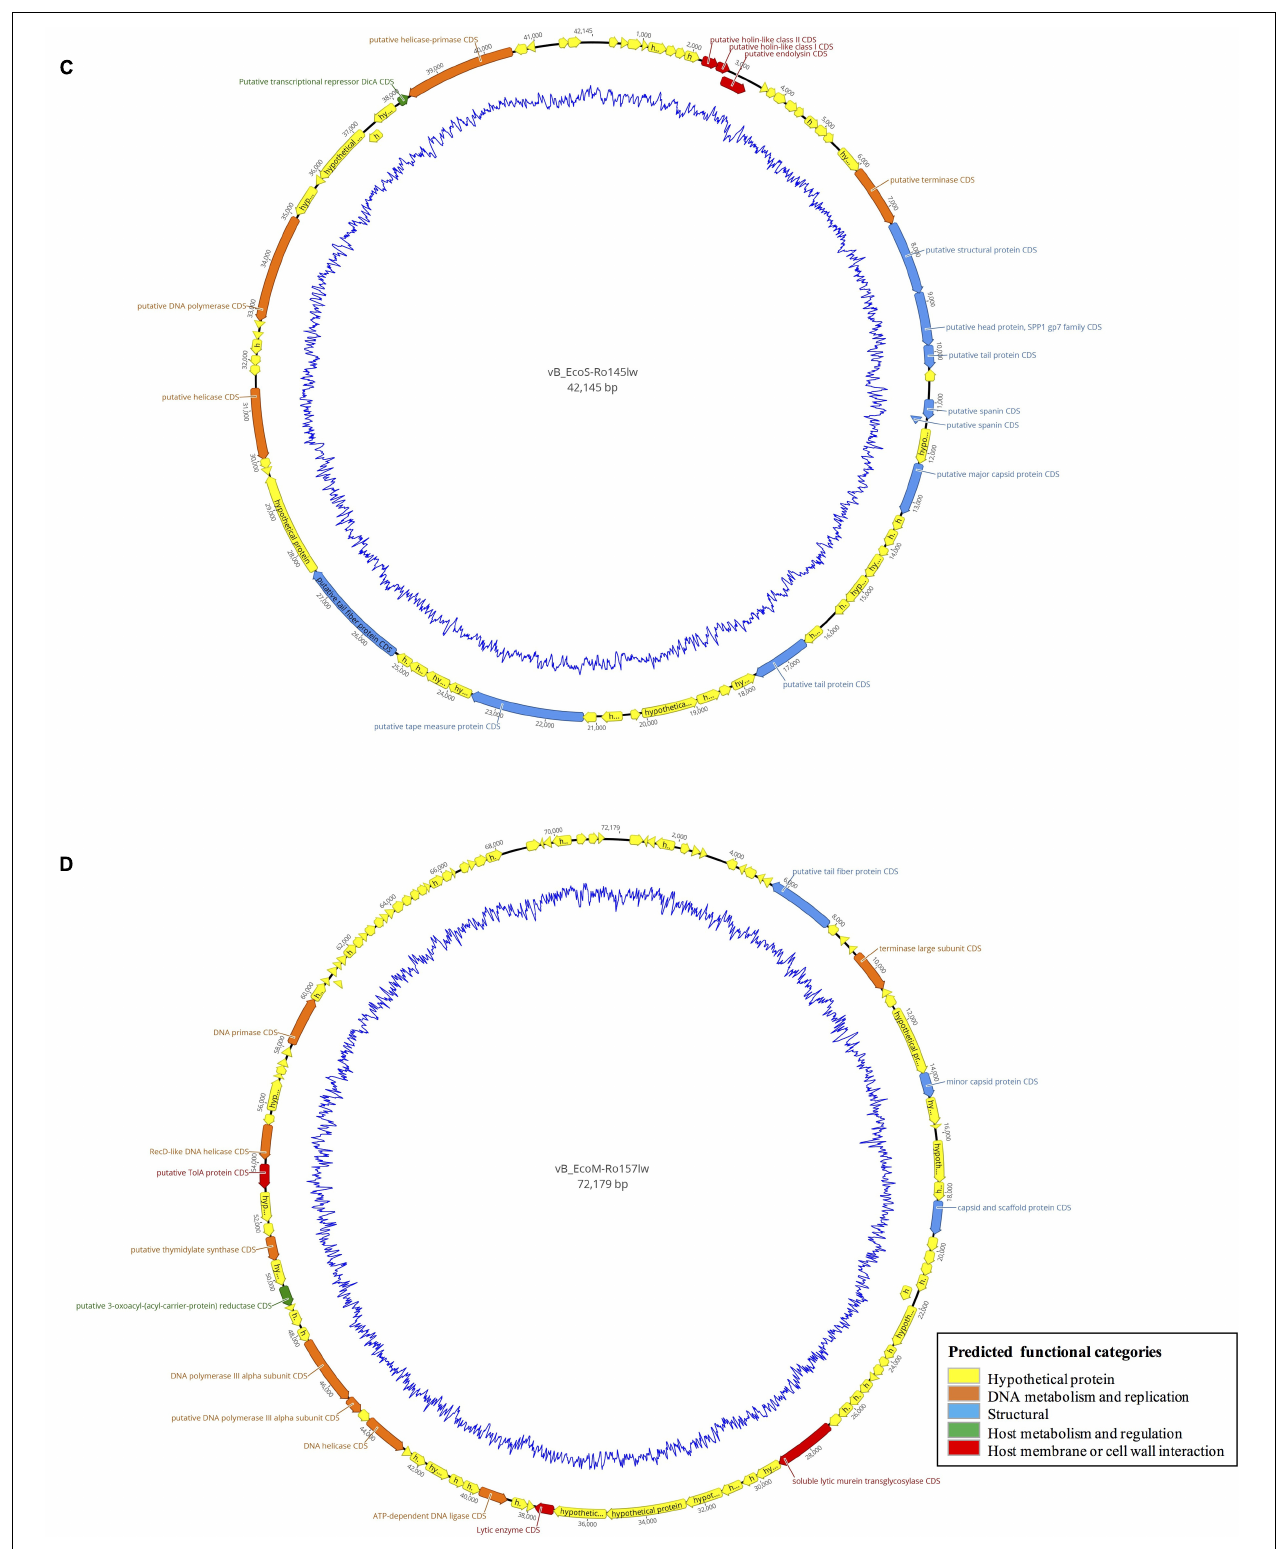
FIGURE 3 | Circular genome map of the phages vB_EcoM-Ro111lw (A) , vB_EcoM-Ro121lw (B) , vB_EcoS-Ro145lw (C) , and vB_EcoM-Ro157lw (D) . The outer circle represents genes as indicated by the arrows. Predicted functional categories of the genes were determined according to annotation and are represented with different colors. The central graph in blue shows genomic GC content